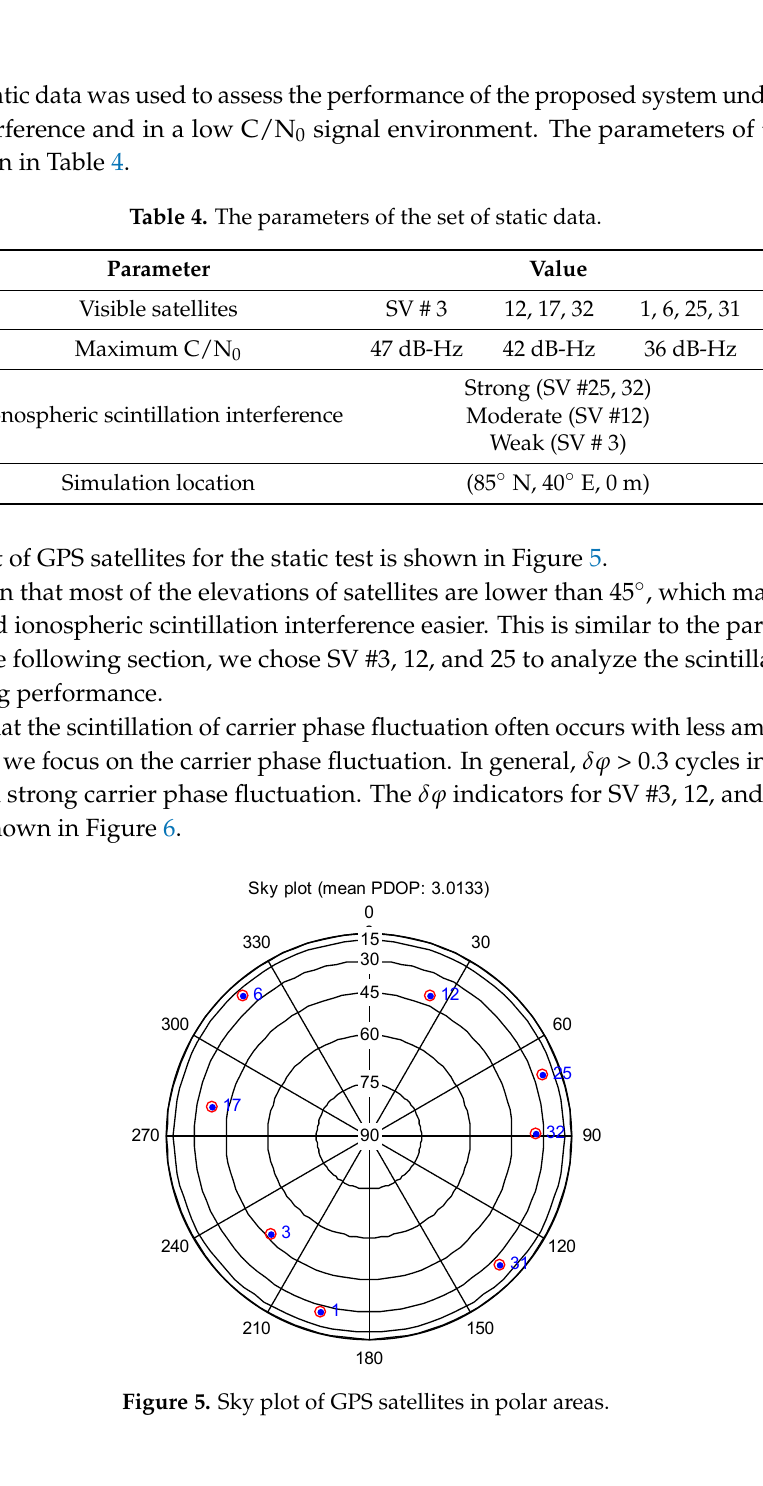
Figure 6.  indices: ( a ) weak scintillation for SV #3; ( b ) moderate scintillation for SV #12; ( c ) strong scintillation for SV #25. From Figure 6a we can see that nearly all  indices for SV #3 are smaller than 0.1 during the simulation time, which can be considered as weak scintillation. Meanwhile, Figure 6b shows that most of the  indices for SV #12 fluctuate between 0.13 and 0.15, which can be regarded as moderate scintillation. Several  values approach and even exceed 0.3 for SV #25 in Figure 6c, which represents strong scintillation. Then, the carrier phase lock indicator (PLI) was used as the criterion of carrier phase tracking performance; it can be expressed as